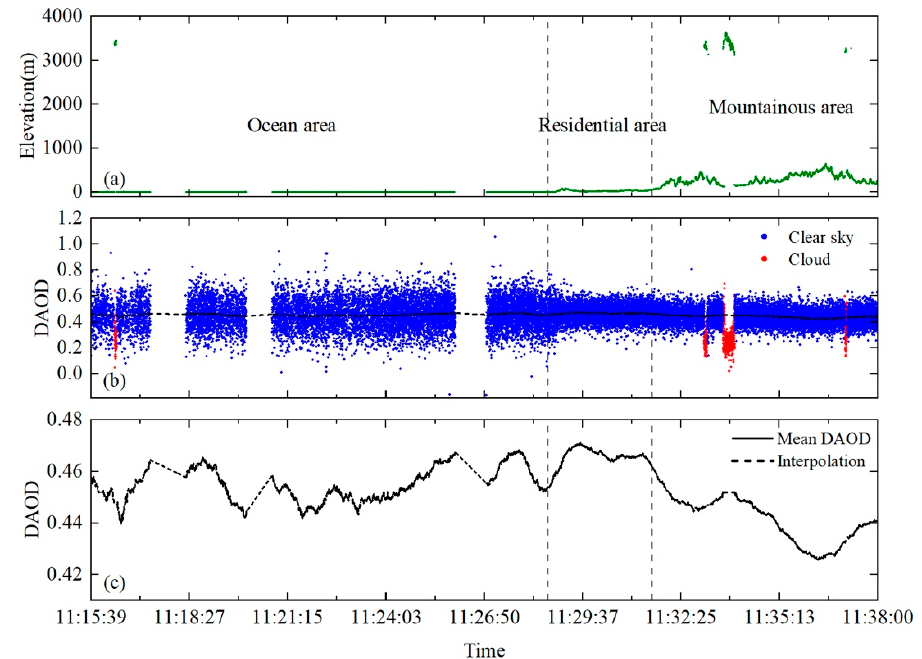
Figure 3. The DAOD measurements of CO 2 from IPDA lidar on 14 March 2019. The blue and red dots are single shot measurements and the black line is the result of 1500-point averages. The gaps between observations indicate the interval of missing and unavailable measurements. The dashed vertical lines indicate the boundaries of the different surfaces.